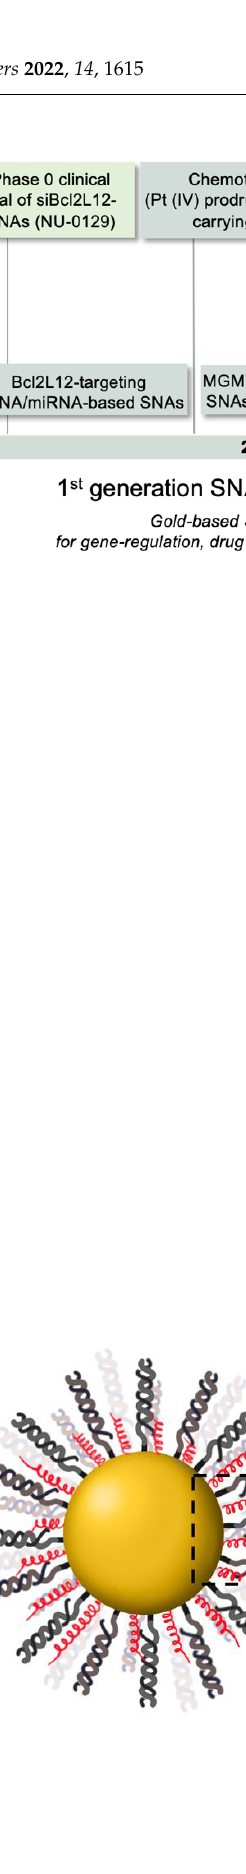
Figure 2. Gold-based SNAs for gene regulation and delivery of chemotherapeutic and imaging agents. OEG, oligo (ethylene glycol); PEG, poly (ethylene glycol); Gd III , gadolinium III; siRNA, small interfering RNA; miRNA, microRNA.